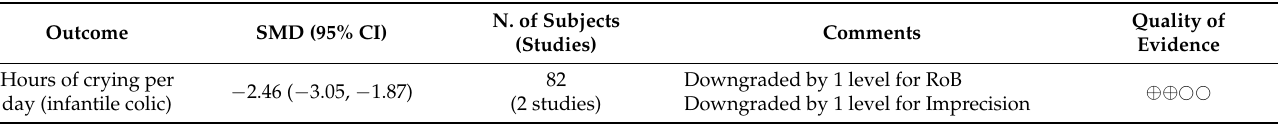
Table 3. Quality of evidence assessed through GRADE